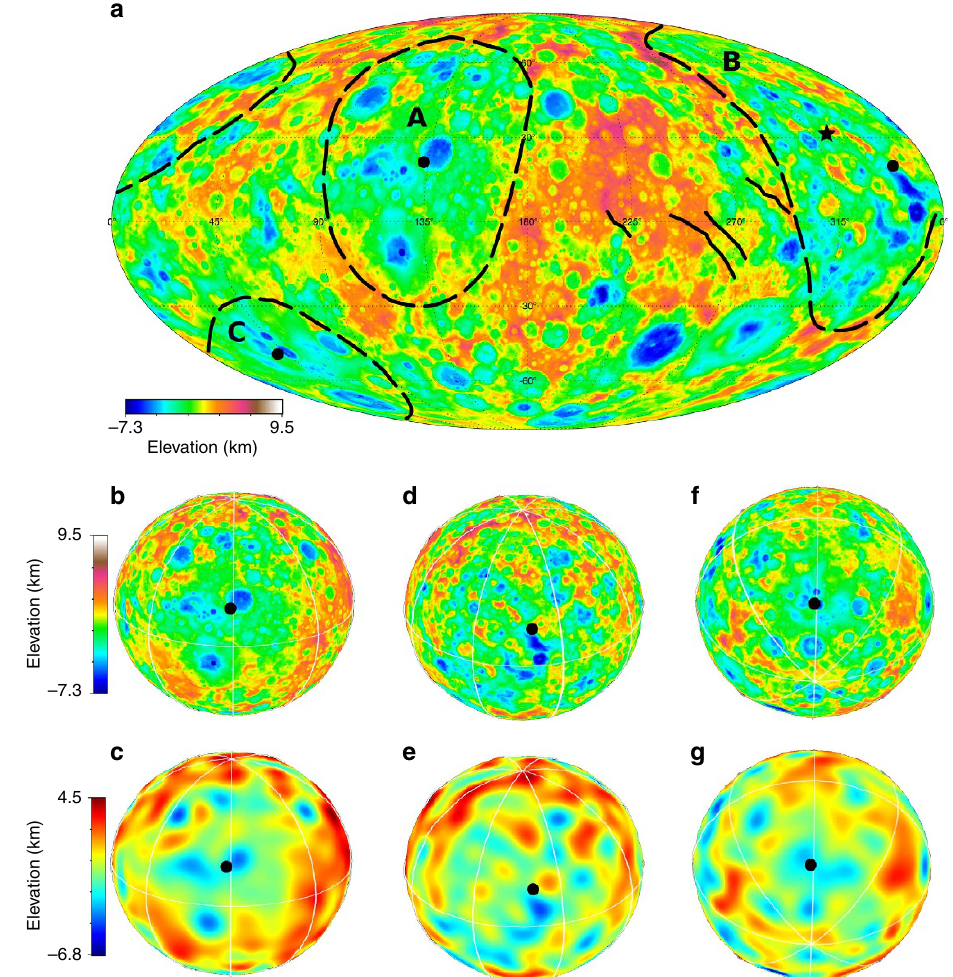
Figure 7 | Planitia B and C. ( a ) Mollweide projection of Ceres’ topography. ( b , c ) Real and filtered topography views centred at Vendimia Planitia, planitia B ( d , e ) and planitia C ( f , g ). Dashed black lines indicate the three major depressions or planitiae; while black dots indicate their approximate centres. ( b – g ) White lines indicate 45 (cid:2) -spaced meridians and the equator. Topography range is (cid:2) 7.3 to þ 9.5km, while filtered topographic range is (cid:2) 6.8 to þ 4.5km. The latter has been derived by applying a cosine taper to shape spherical harmonic coefficients between degree 15—corresponding to a scale of 200km—and degree